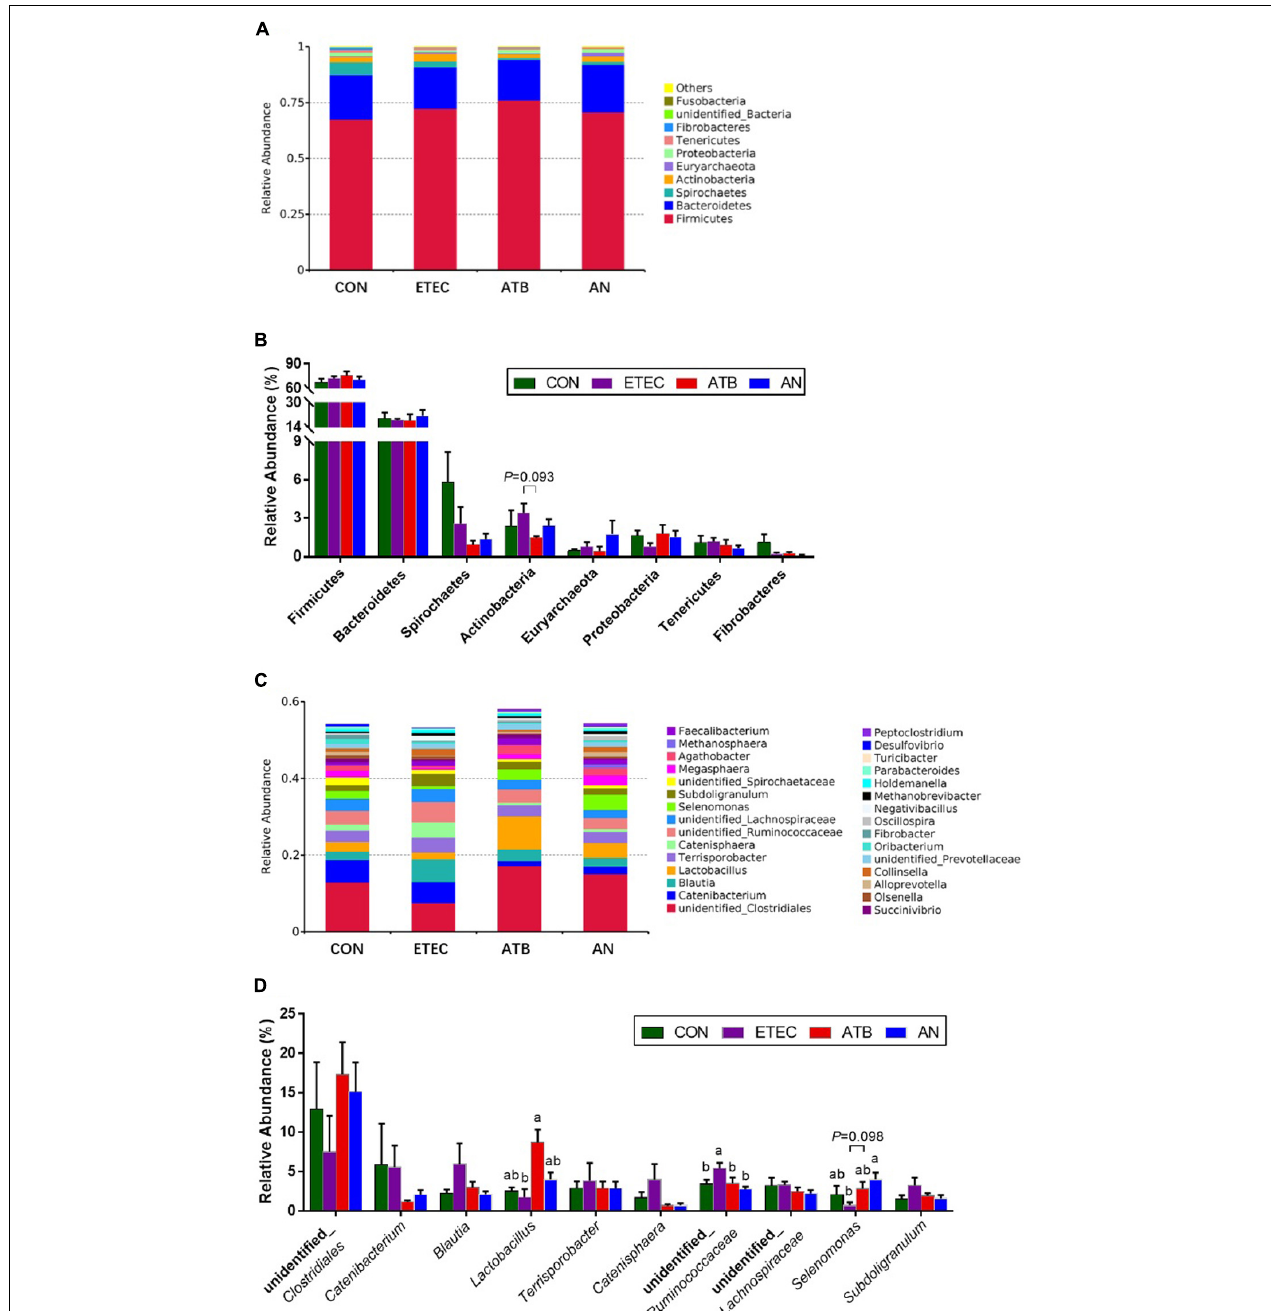
FIGURE 5 | Effect of anethole on microbial composition of fecal microbiota of piglets challenged with enterotoxigenic Escherichia coli K88 (n = 5). (A) Relative abundance in phyla. (B) Top eight in phyla. (C) Relative abundance in genus. (D) Top 10 in